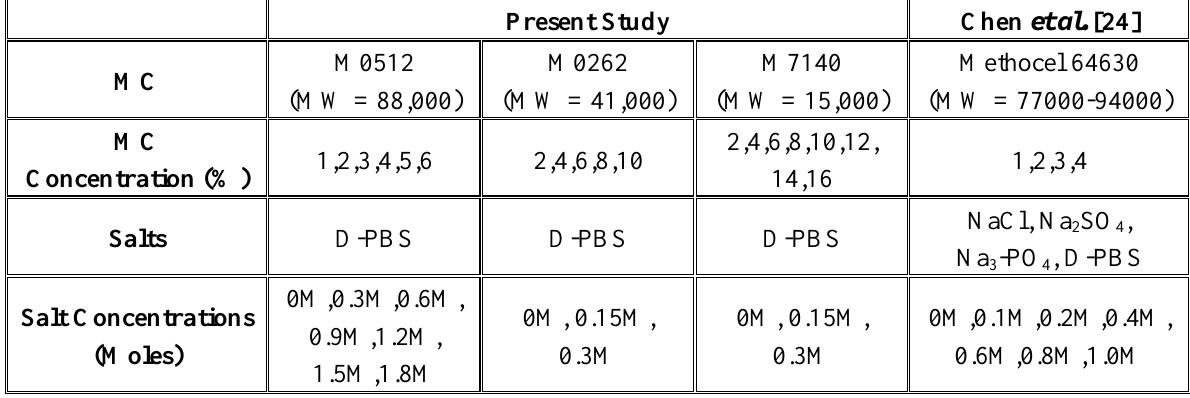
Table 1. Comparison of the formulations tested in this study with that of Chen et al .